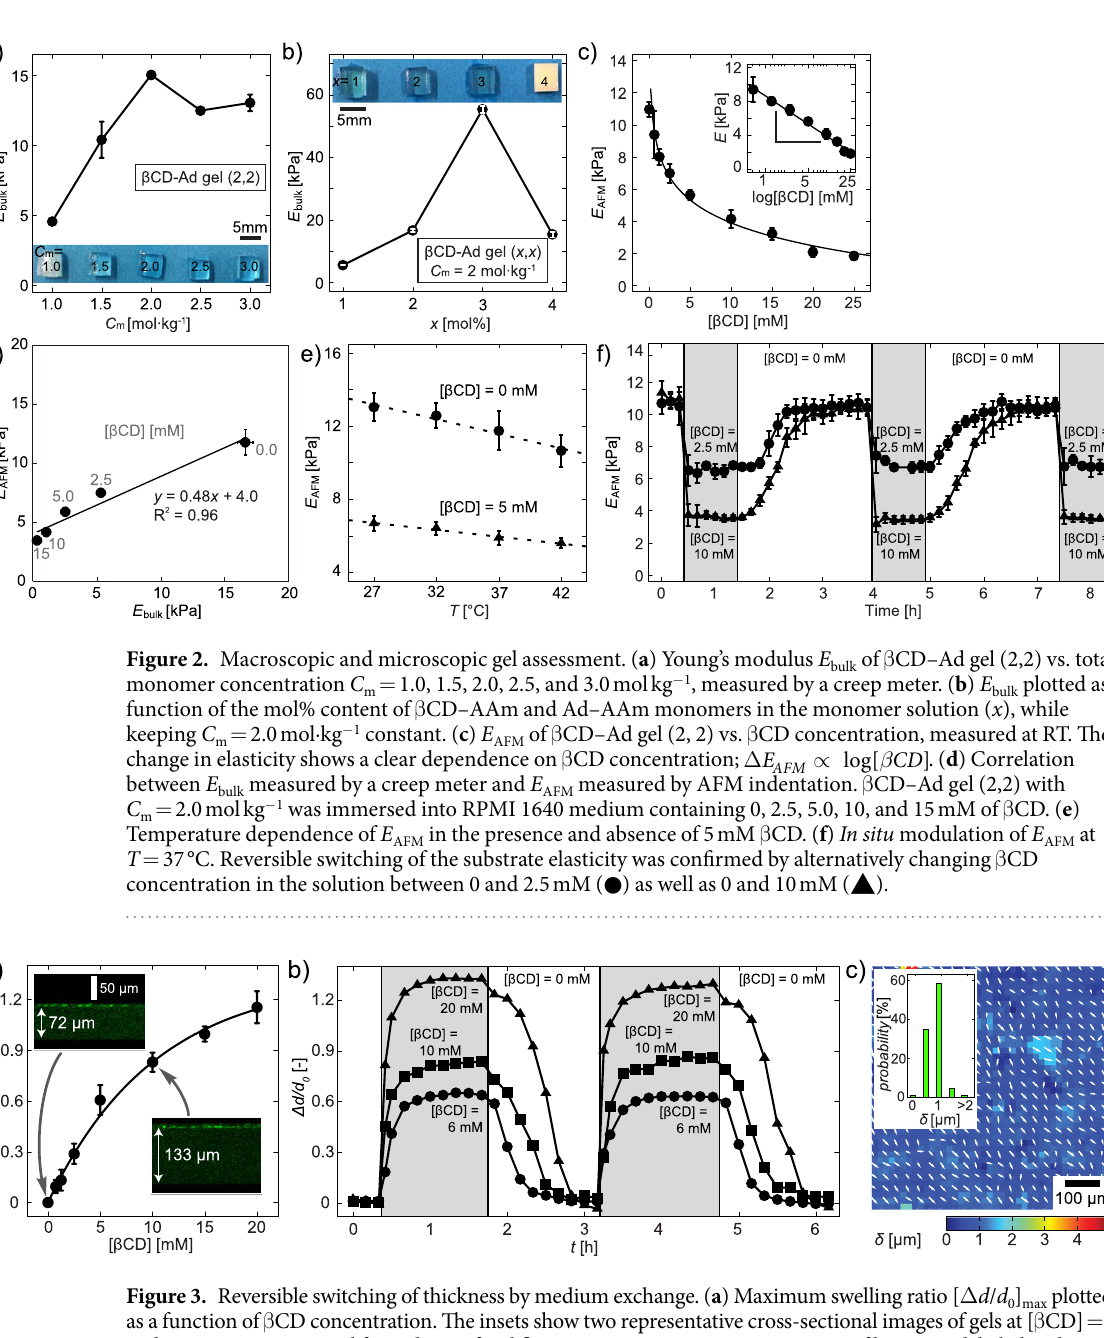
host-guest gel, and monitored the lateral displacement caused by swelling using confocal microscopy (Supporting Information S4). Figure 3c represents the lateral deformation of the gel analyzed by measuring the displacement of embedded fluorescent beads and using particle image velocimetry (PIV) after the incubation in the medium containing 10 mM β CD. The magnitude of displacement is indicated by the color code, while arrows indicate the direction. Although the swelling of the film is Δ d max ≈ 60 µ m, as shown in Fig. 3a, the histogram of displacement (inset) implies that the lateral displacement is ≤ 1 µ m for more than 90% of the beads. This finding confirms that exposure to β CD induces swelling of host-guest gels in the direction normal to the substrate but does not exert